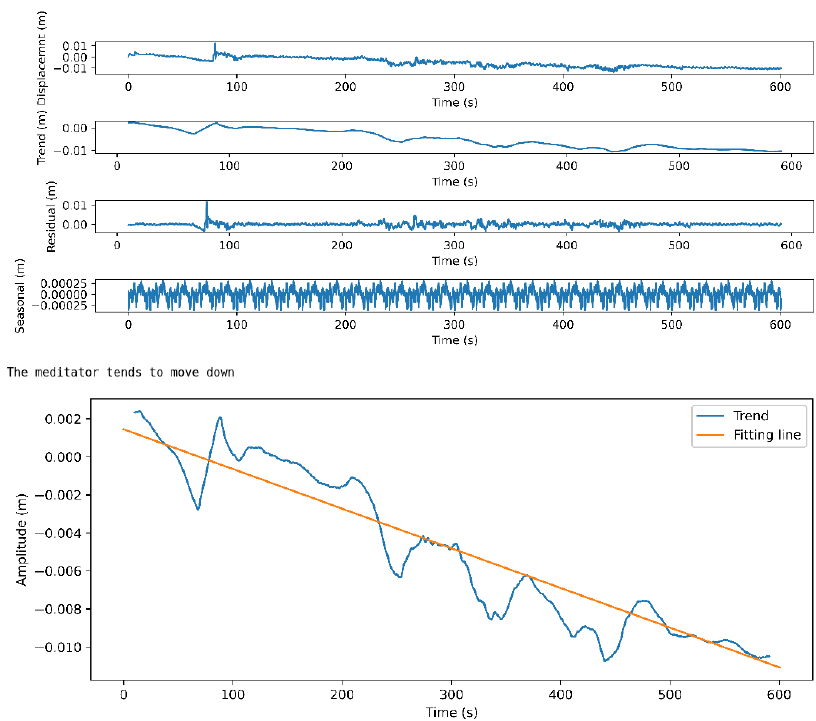
Figure 13. Full body up/down movement analysis for a beginner